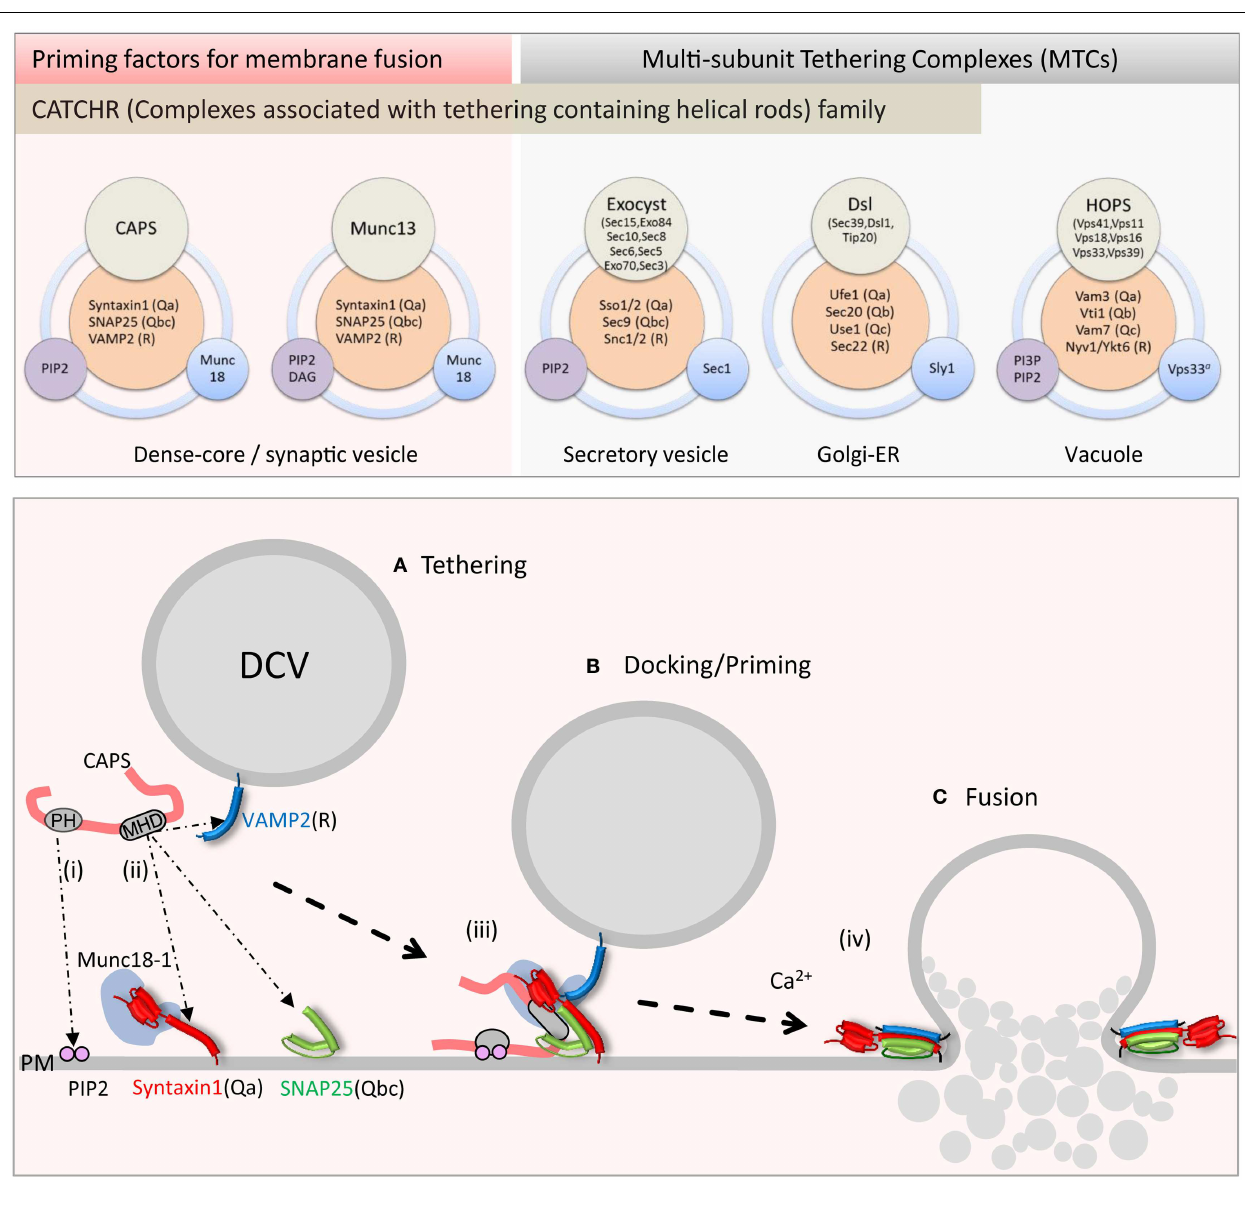
function in vesicle priming depicting (i) PH domain binding to PIP 2 and (ii) MHD1-mediated SNARE binding. Simultaneous binding of vesicle and plasma membrane constituents by CAPS might tether vesicles (A) in proximity to the SNARE proteins.These interactions could lead to (iii) syntaxin-1/SNAP-25 heterodimer formation followed byVAMP2 insertion to form trans-SNARE complexes in priming (B) . (iv) Full SNARE complex zippering in response to elevations of intracellular calcium mediated by synaptotagmin and complexin triggers vesicle fusion (C) and contents release into the extracellular